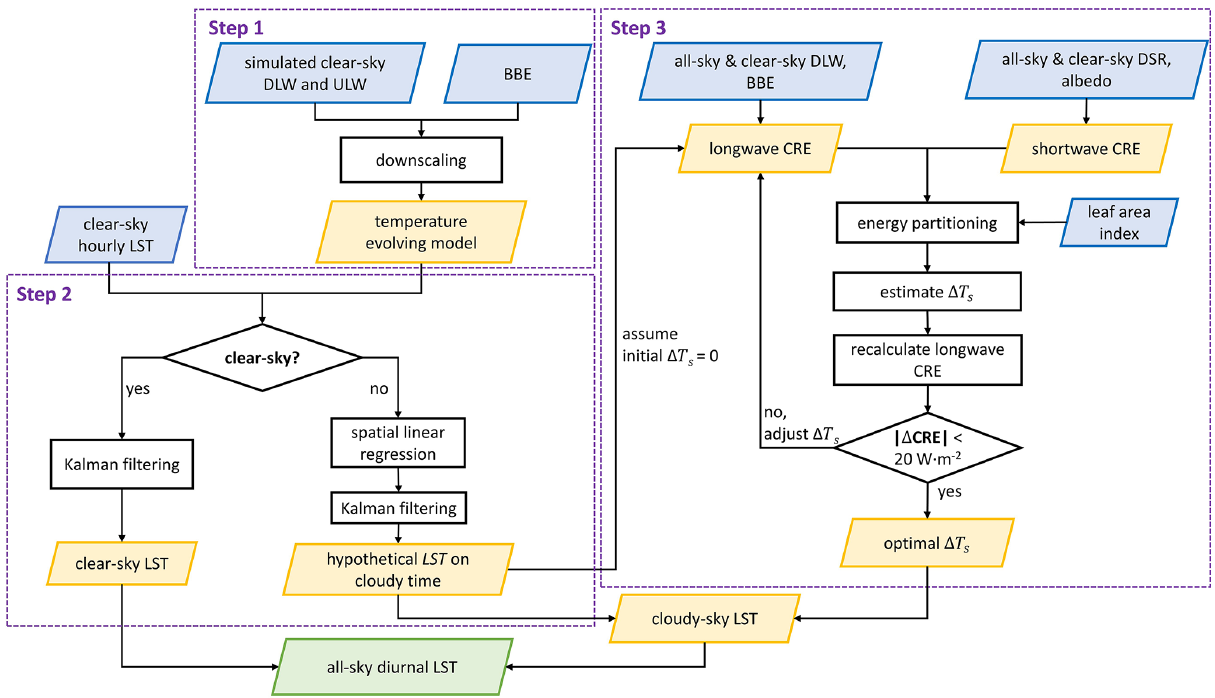
Figure 3. Flowchart of the proposed GHA-LST dataset production. The abbreviations used in the figure are as follows: DLW – downward longwave radiation, ULW – upward longwave radiation, DSR – downward shortwave radiation, BBE – broadband emissivity, LST – land surface temperature, and CRE – cloud radiative